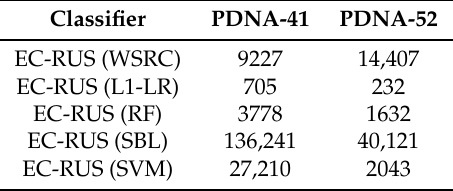
Table 9. The running time (seconds) of EC-RUS on PDNA-41 and PDNA-52 independent testing